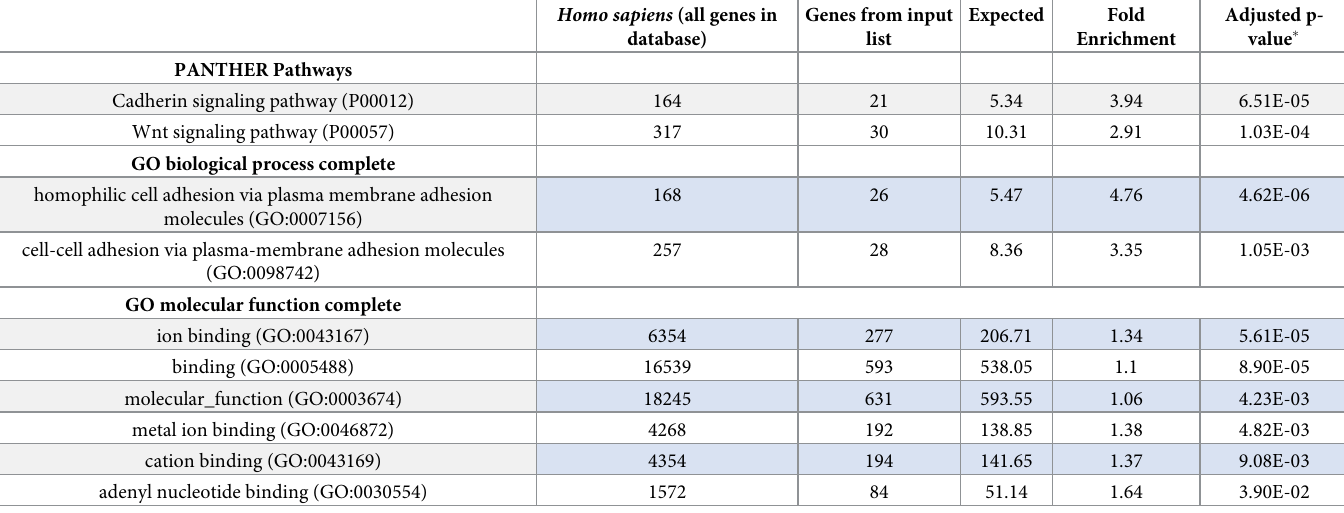
Table 5. Bioinformatic functional assessment of more methylated AHC profile DMRs via PantherDB.